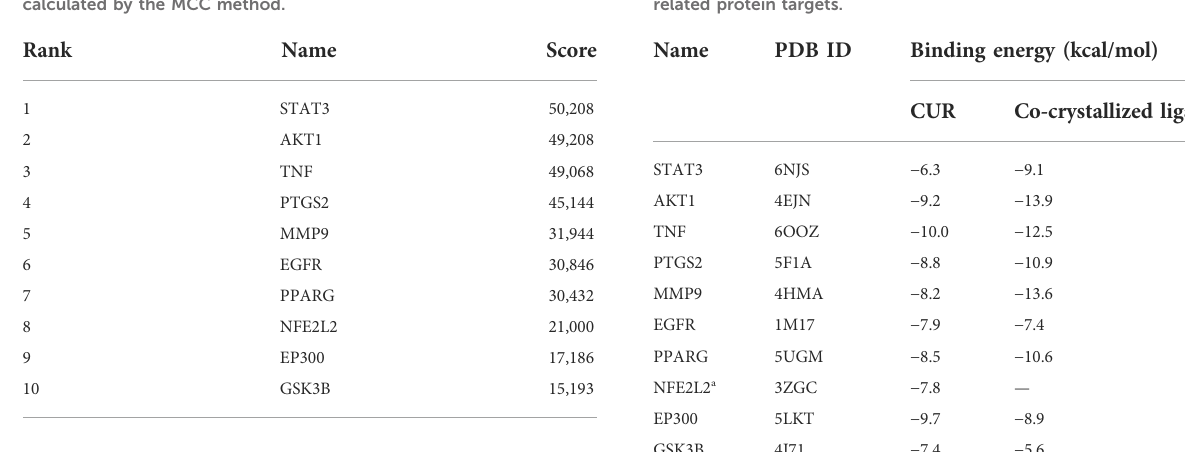
TABLE 2 The binding energies of CUR or co-crystallized ligands with related protein